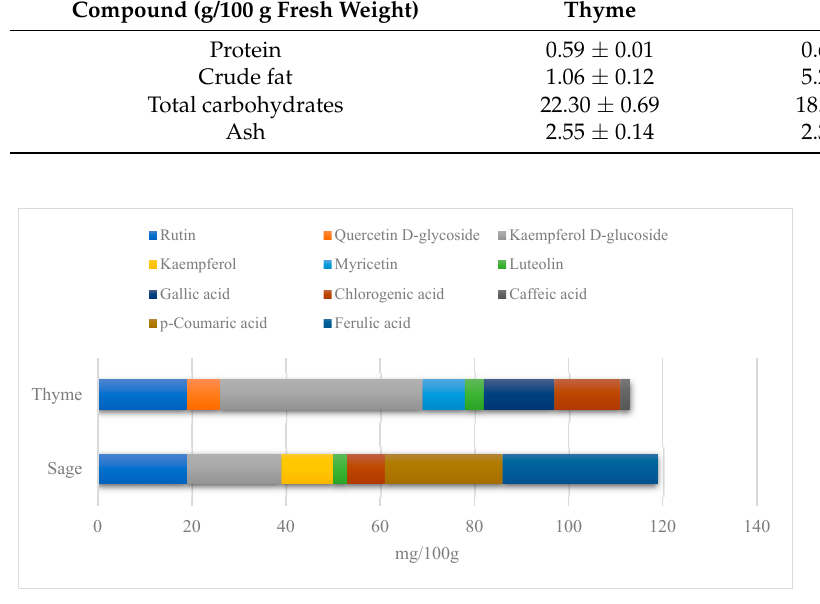
Figure 2. Polyphenolic compounds of thyme and sage. Adapted from